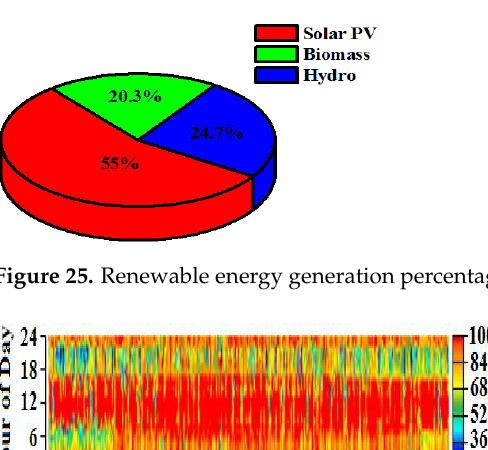
Figure 24. Electrical energy generation on a monthly basis for case IV (Ba/Bi/H/S).